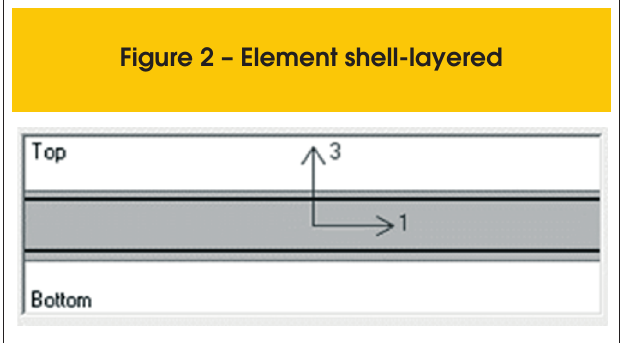
Figure 2 – Element shell-layered